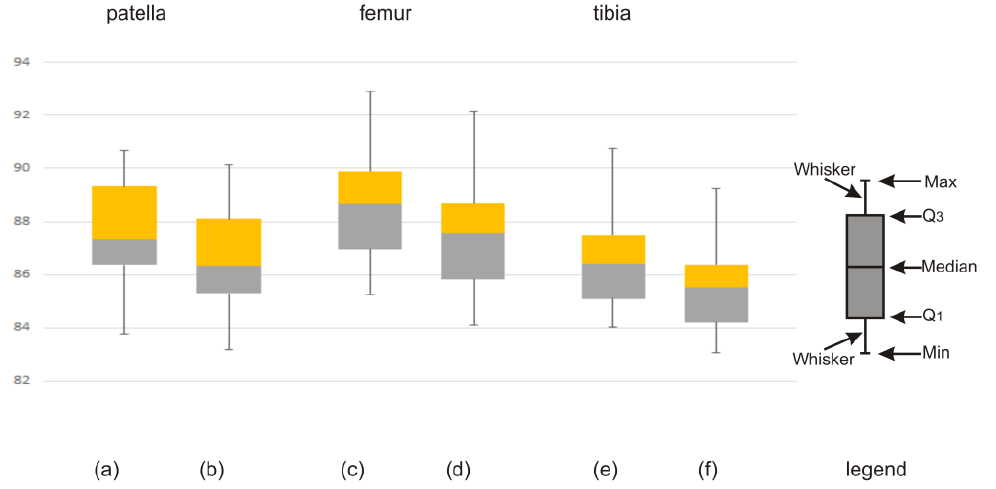
Figure 9. Discrepancy in the obtained values of the Dice index: ( a , c , e ) atlas-based segmentation combined with FC method (T1-weighted MRI studies of the knee joint) and ( b , d , f ) atlas-based segmentation combined with FCM method (T1-weighted MRI studies of the knee joint) for patella, femur, and tibia,